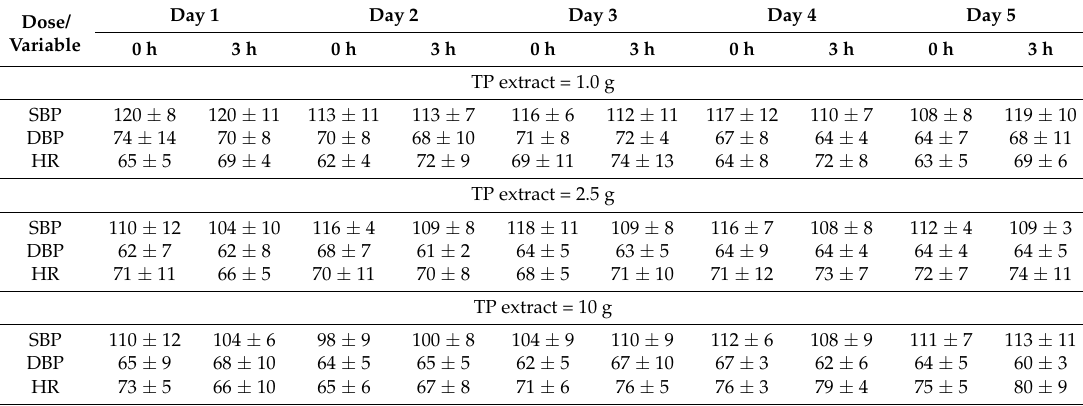
Table 2. Changes in SBP/DBP and HR after ingestion of tomato pomace extracts across 3 different doses (Phase 1 study: